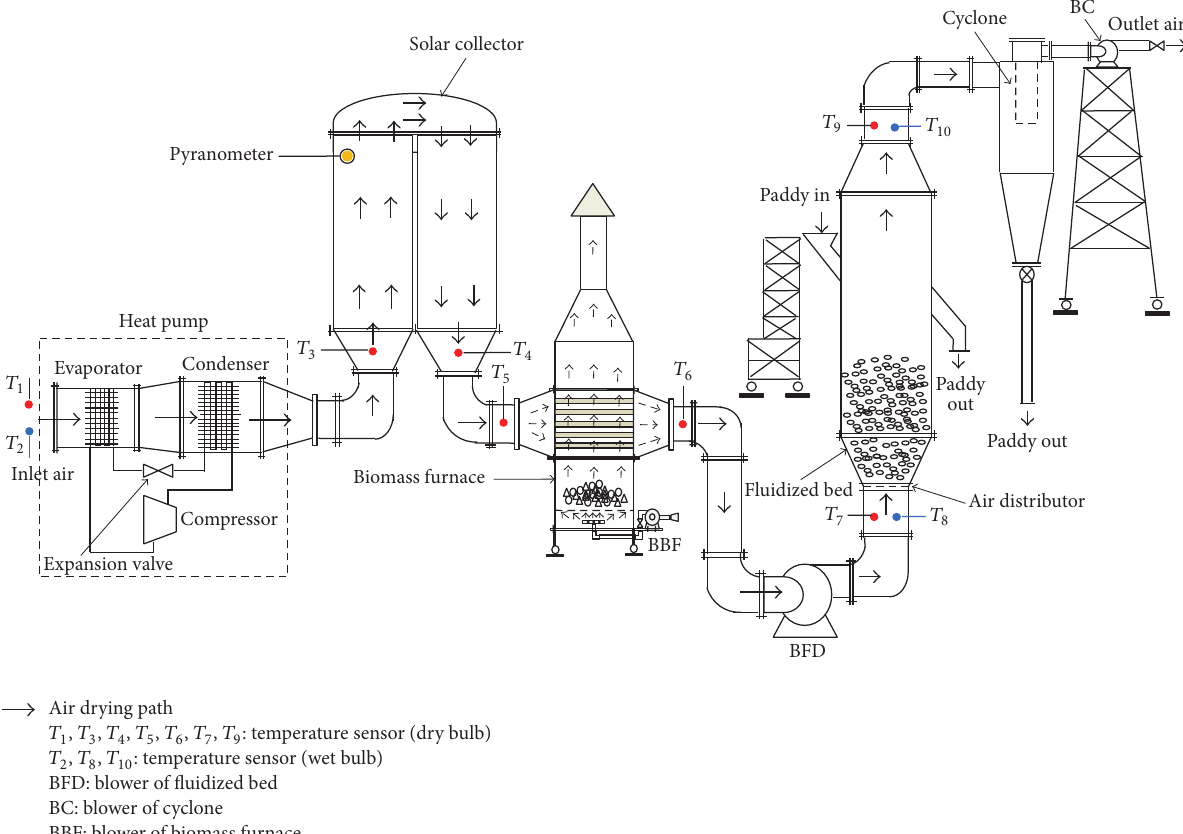
Figure 7: Schematic diagram of SA-FBDIBF (mode